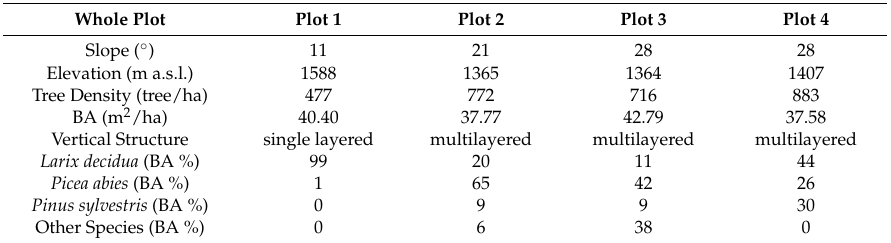
Table 1. Site characteristics, stand structure descriptors, and species composition of the four permanent plots as a whole and considering only the felled trees. Tree heights were obtained from DIR measurement, instead diameter at breast height (DBH), basal area (BA), bole height (Crown H), and crown area (Crown A) were obtained from IND survey